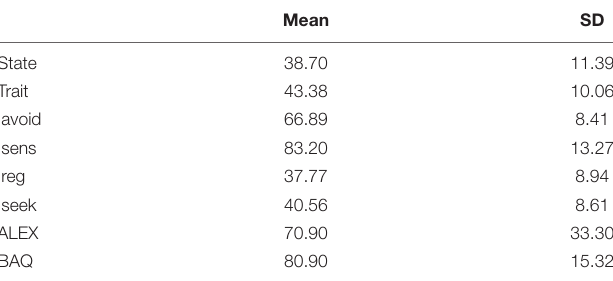
TABLE 2 | Means and standard deviations of the measures in the study.